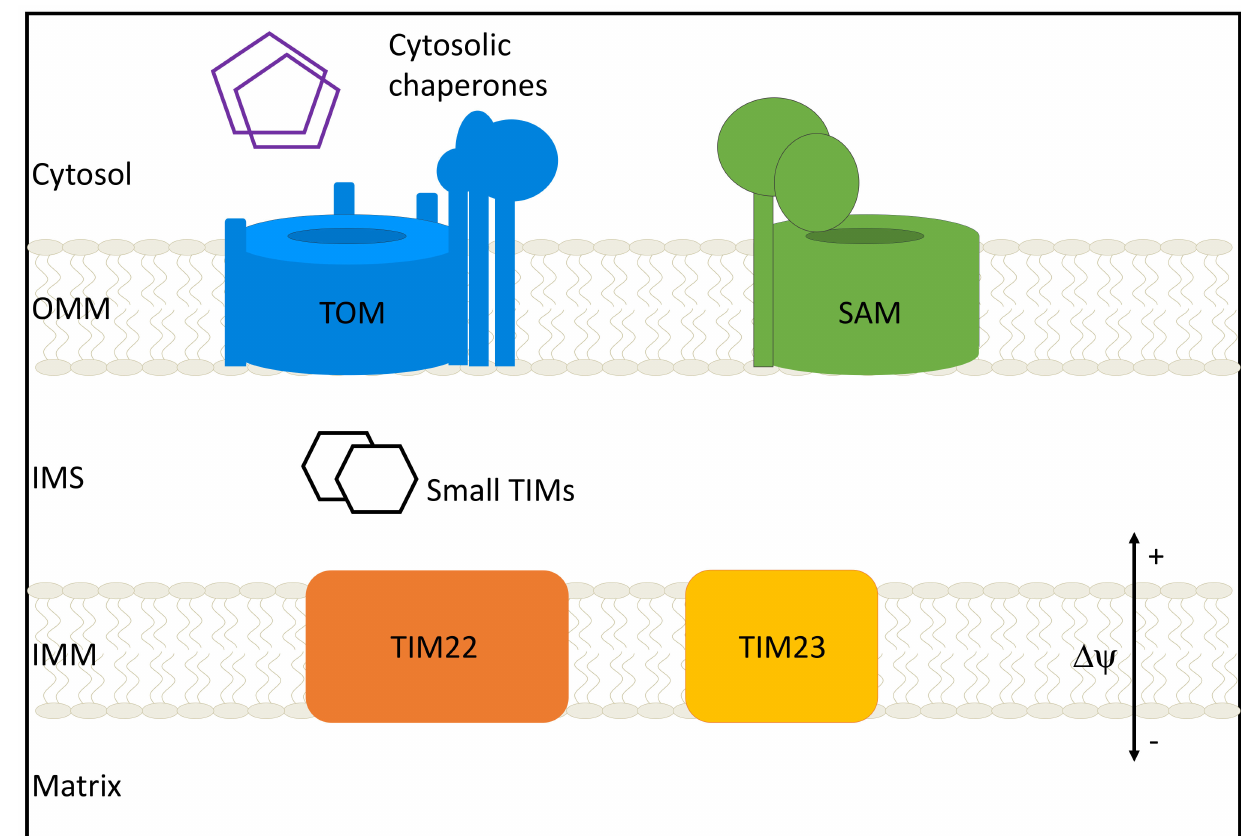
Figure 1. Mitochondrial protein import machinery. The bulk of protein import occurs through the translocase of the outer membrane (TOM) complex. Cytosolic chaperones aid in this process by preventing aggregation of preproteins. After traversing the TOM complex and entering the intermembrane space (IMS), proteins can follow one of several general import pathways: β -barrel proteins are inserted into the outer mitochondrial membrane (OMM) by the sorting and assembly machinery (SAM) complex; Carrier proteins are inserted into the IMM by TIM22; Proteins destined for the inner mitochondrial membrane (IMM) or matrix are imported and integrated by TIM23; small TIMs support protein transfer from IMS to